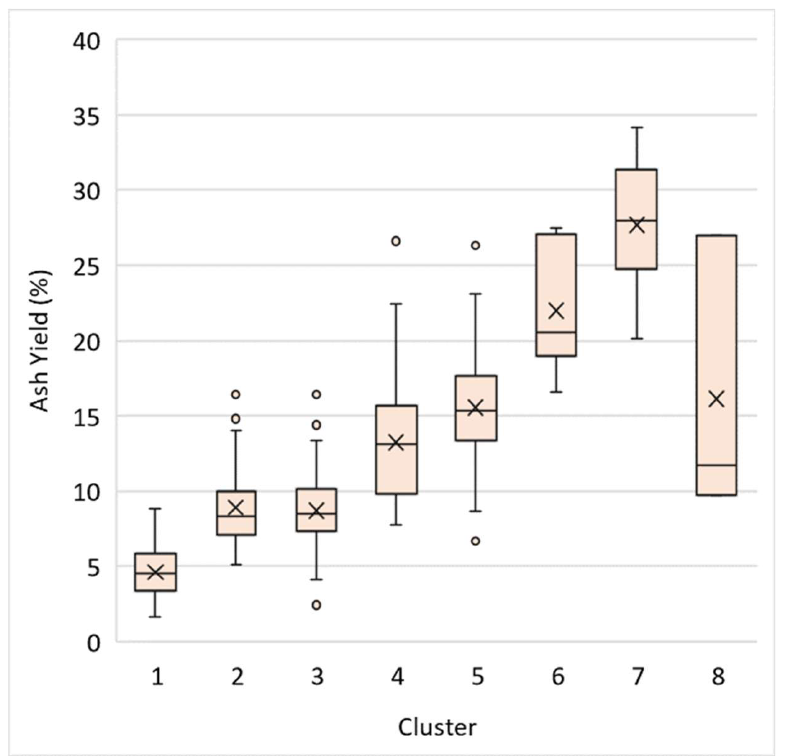
Figure 8. Boxplot showing ash yields for K-means clusters. Mean values are represented by an “X”.